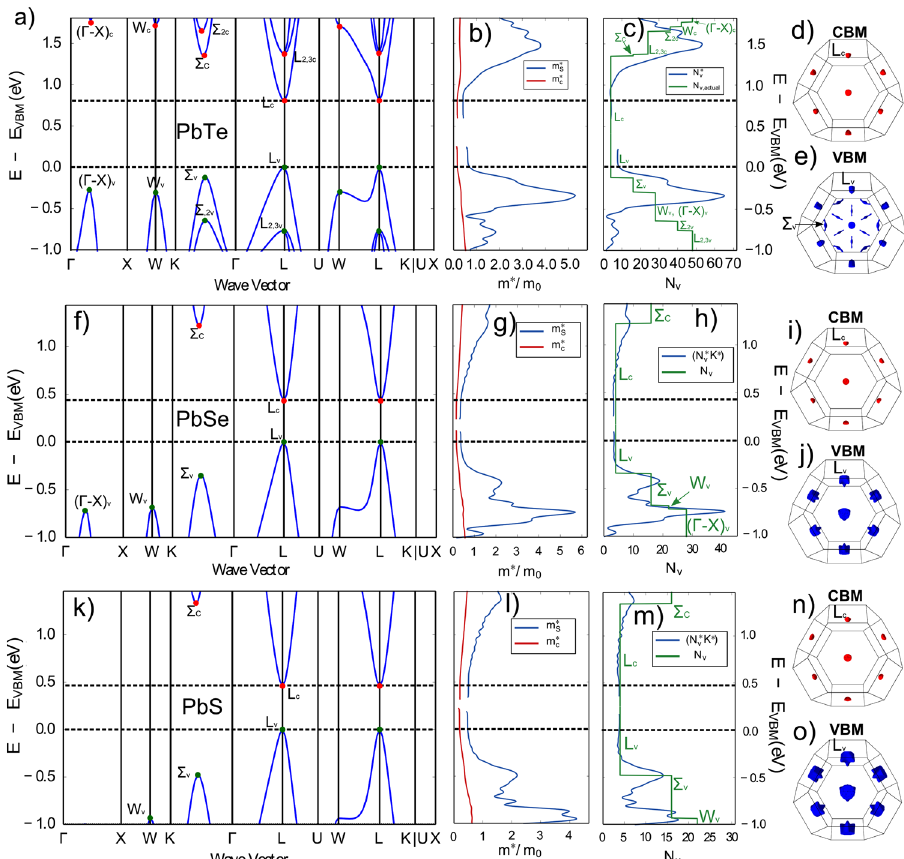
Fig. 2 Band structure, m * c and m * S versus Fermi level, and N * K * at 300 K versus Fermi level, and valence and conduction band Fermi surfaces for v PbTe ( a – e ), PbSe ( f – j ), and PbS ( k – o ). The valence and conduction band edges are shown as a dashed line . Fermi surfaces are drawn at 0.1 eV above the conduction band edge (CBM) for PbTe, PbSe, and PbTe, respectively, or 0.13, 0.3, and 0.4 eV below the valence band edge (VBM) for PbTe, PbSe, and PbS,